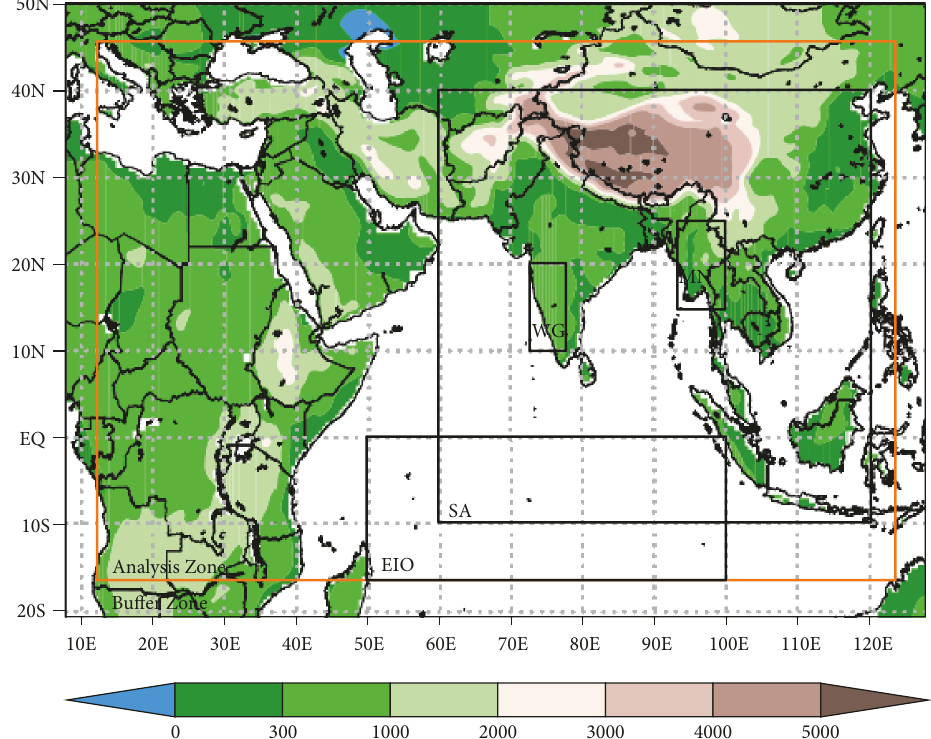
Figure 1: Regional model domain and orography (m) of the downscaling experiment for CORDEX- South Asia. The analysis zone is used throughout the experiment (indicated by an orange box) excluding the buffer zone (five grid columns from each side). Black boxes indicate the subdomains selected for study. The coordinates of analysis zone and subdomains are given in Table 1.